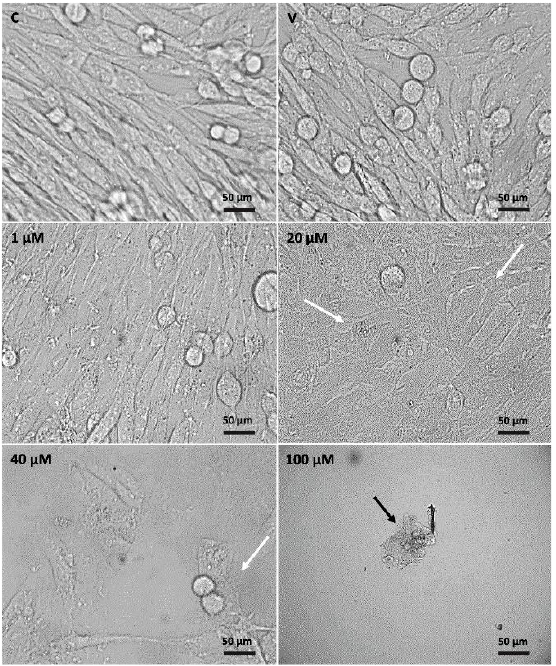
Figure 4. Morphological alterations in untreated C6 cells and after treatment with eleutherine at different concentrations (1, 20, 40, and 100 µM) for 12 h. Cells were examined using a phase-contrast microscope (Leica DMI6000B). White arrow indicates irregularly shaped cells with cytoplasmic shrinkage and black arrow indicates cell death. Images were taken using a 63 × objective; C, control; V,